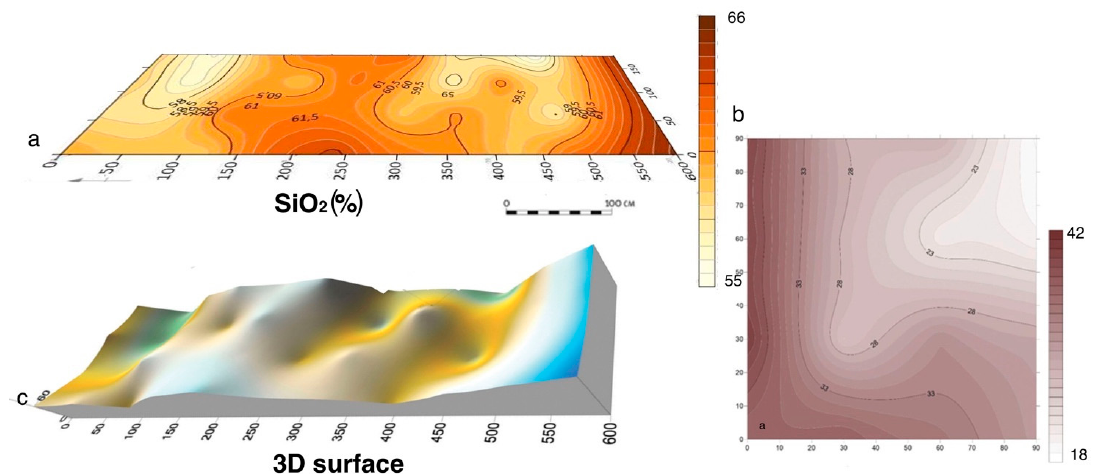
Figure 12. The Tarkhankhut 18 site. Geochemical maps of SiO 2 distribution in the sediments of ( a ) inside cattle pen; ( b ) background pit; ( c ) 3D reconstruction surface based on SiO 2 distribution [43], designed by M.Kulkova.